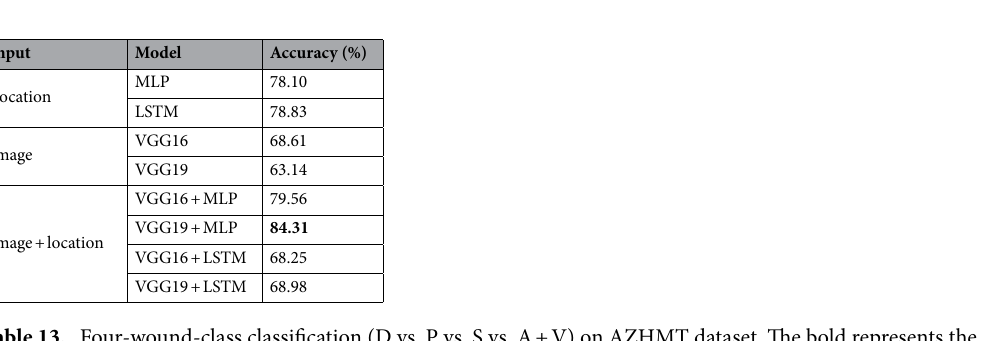
Table 13. Four-wound-class classification (D vs. P vs. S vs. A + V) on AZHMT dataset. The bold represents the highest results/accuracy achieved for each